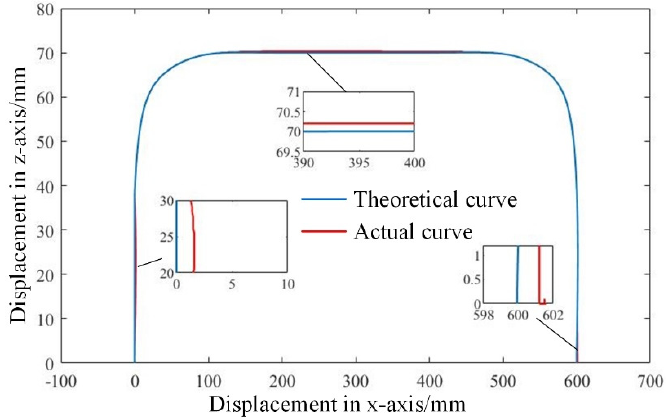
Figure 18. The verification test of the trajectory planning at the execution end.